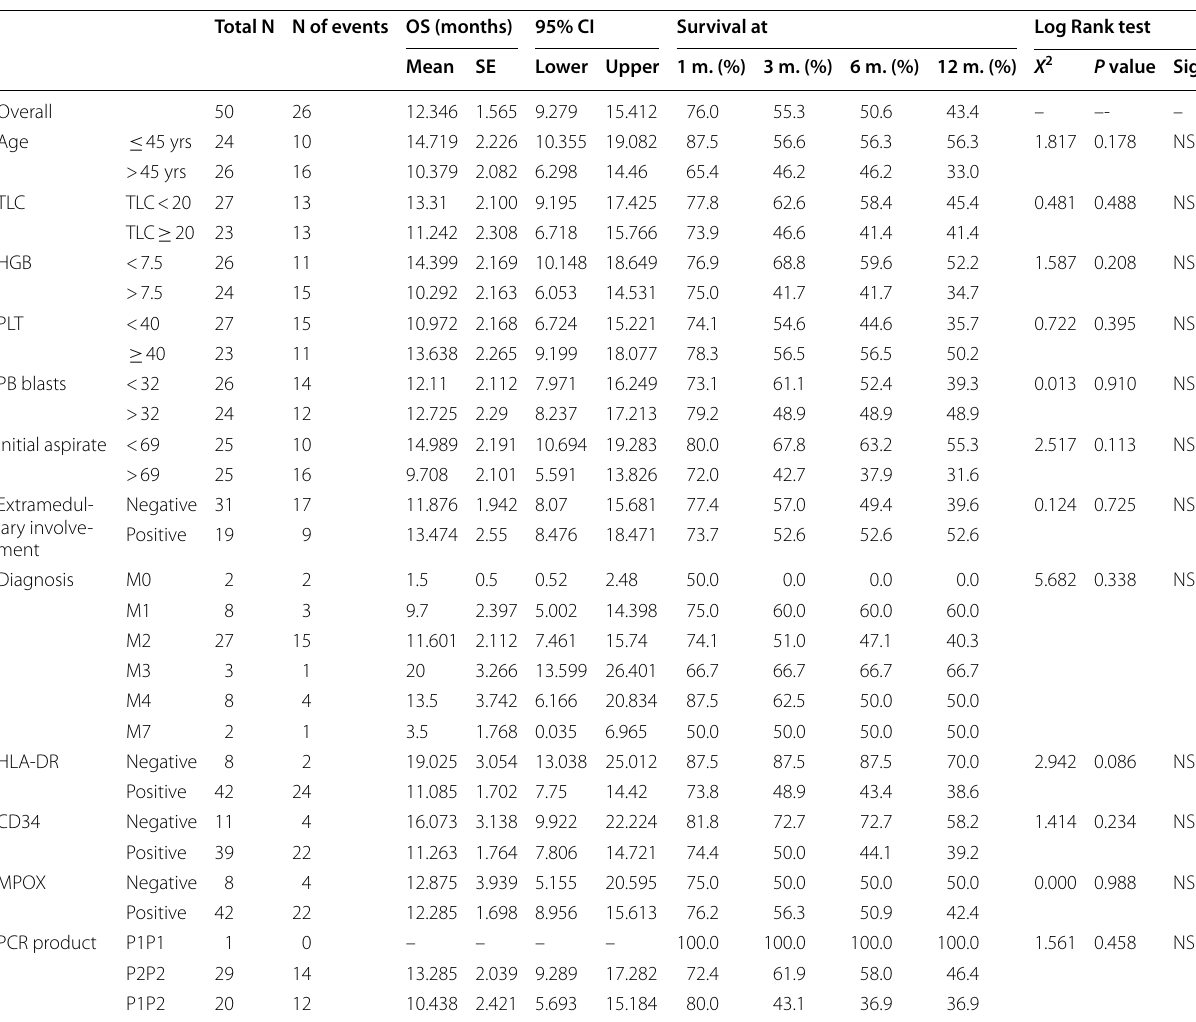
Table 6 Correlation of overall survival with other